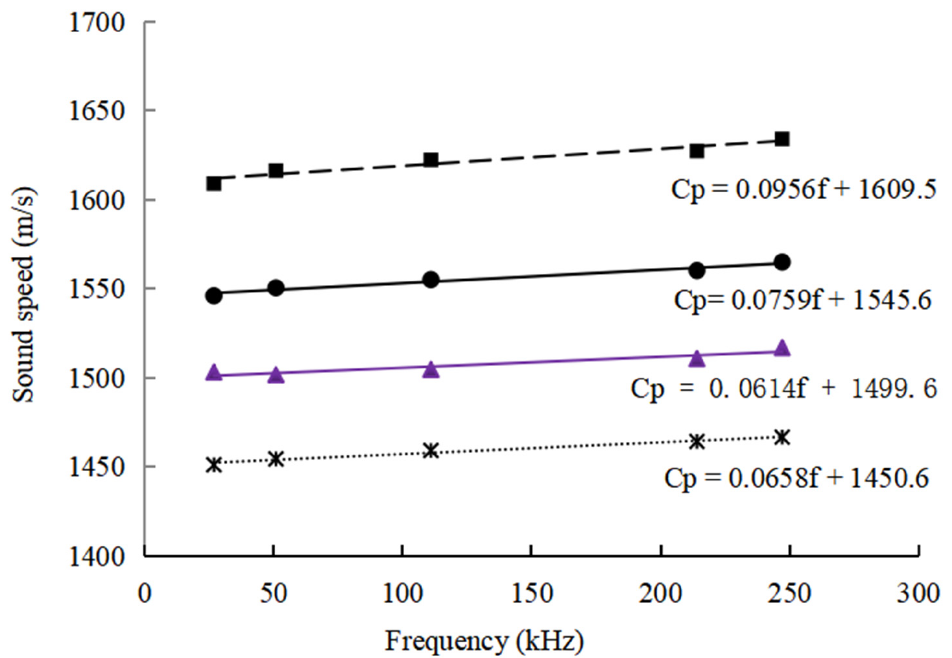
Figure 3. The sound speed dispersion of different sediments. The black ◾ dots are silty sand, the black ● dots are silt, the black ∗ dots are silty clay in SCS, and the purple ▲ is clayey silt in WP.